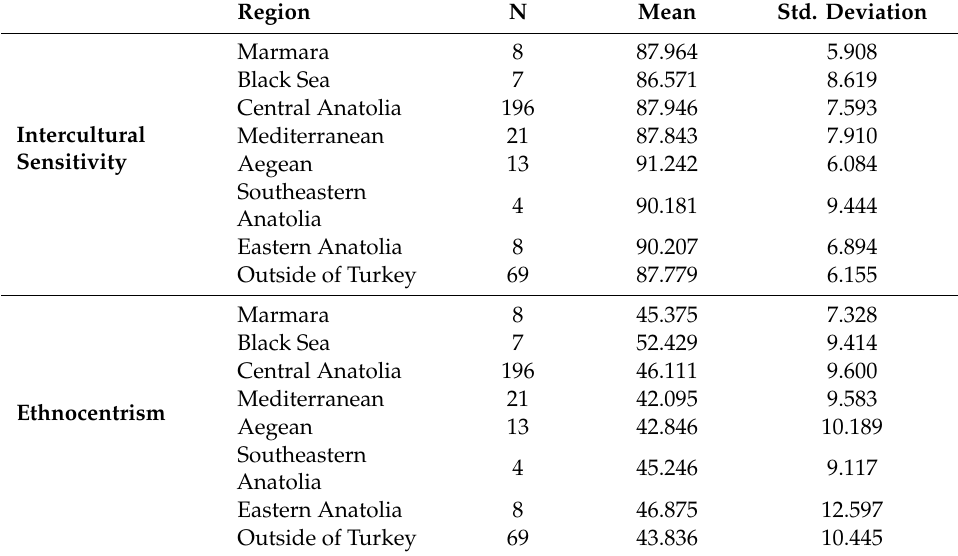
Table 14. Mean and standard deviation of students’ scores by the region in which they live in the Intercultural Sensitivity Scale and the Ethnocentrism